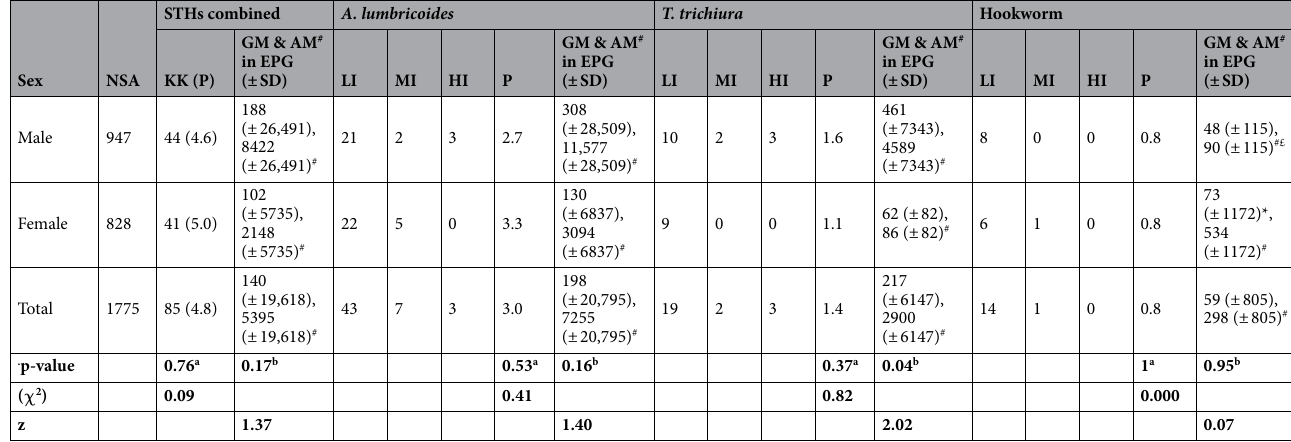
Table 1. Prevalence and infection intensities of soil-transmitted helminth species according to sex. STHs soil transmitted helminths; A. lumbricoides , Ascaris lumbricoides ; T. trichiura , Trichuris trichuria ; NSA number of stool samples analysed; KK overall number of children positive for the kato katz; GM geometric mean egg count; AM # arithmetic mean egg count; SD standard deviation; LI number of children having light infection; MI number of children having moderate infection; HI number of children having heavy infection; EPG egg per gram of stool; P prevalence. Significant values are in [bold]. *Two co-infections. £ Five co-infections. a p-value for chi-square test. b p-value for Mann Whitney U